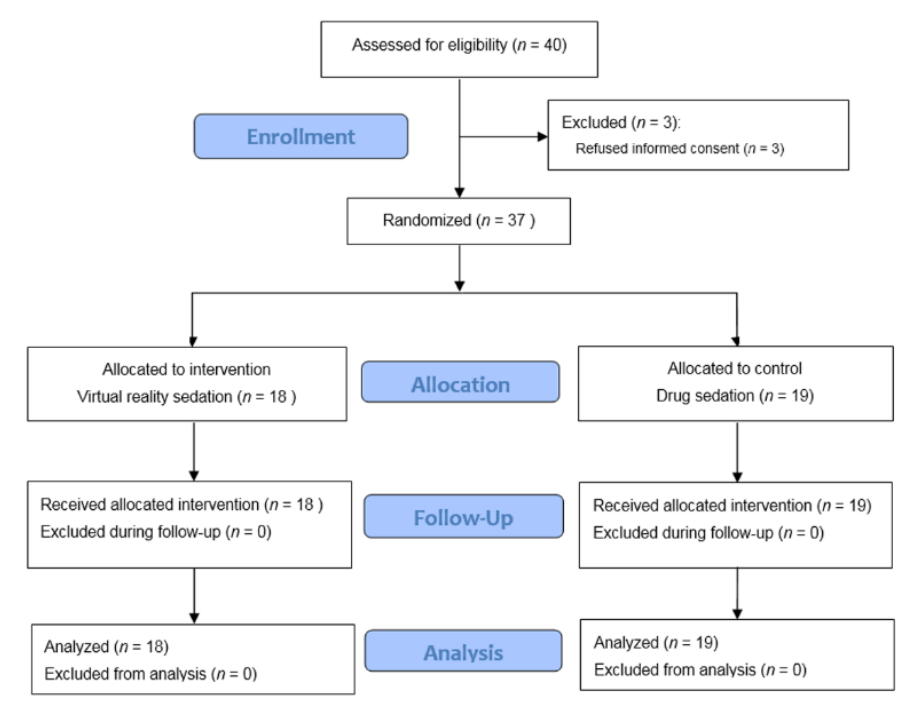
Figure 1. Flow diagram of the study according to CONSORT 2010. Table 2. Baseline characteristics of patients and surgical characteristics.